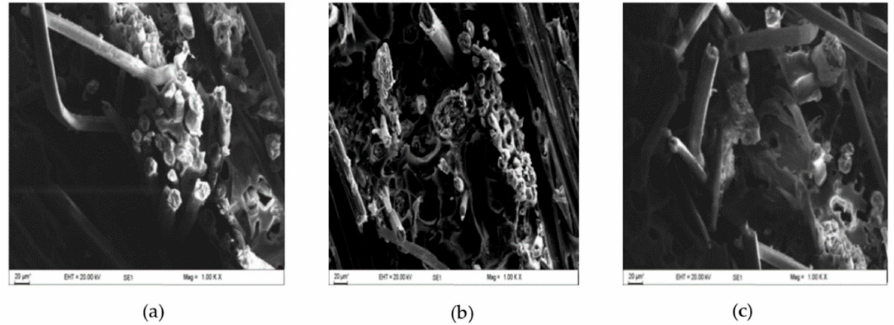
Figure 8. SEM micrograph of fractured specimen of flax fibre composites ( a ) B-flax, ( b ) E-flax and ( c ) P-flax, at 250 ×